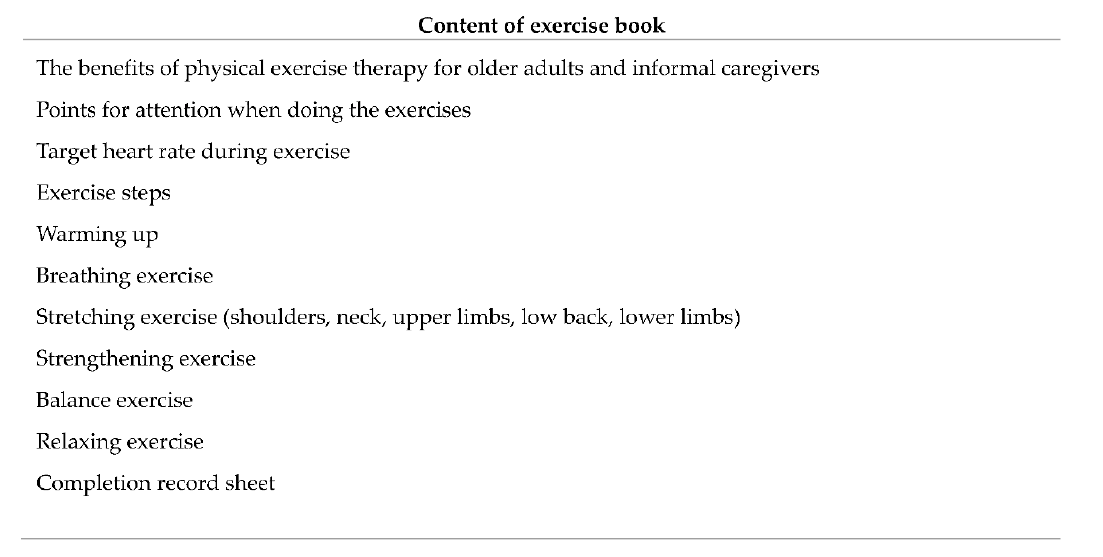
Figure 3. The contents of the exercise book.